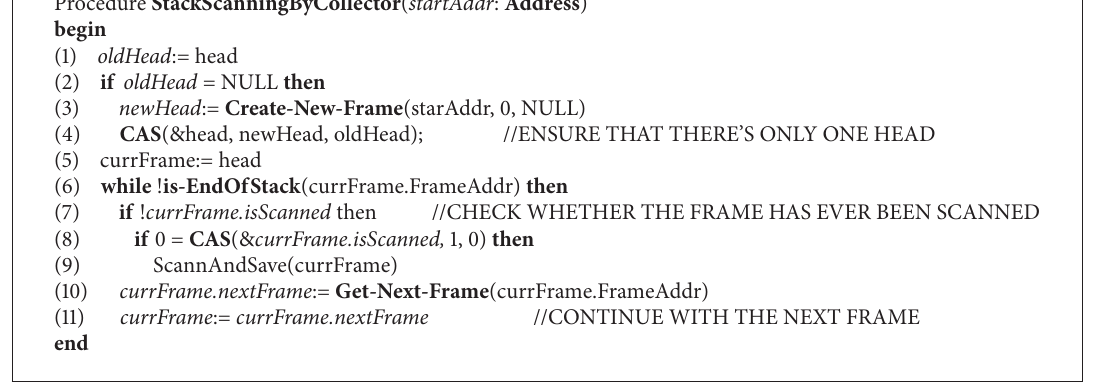
Algorithm 2: Stack scanning procedure of collector thread.